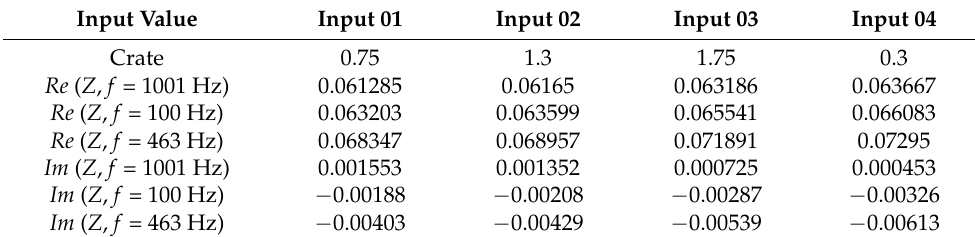
Table 2. Input parameters of the ANN-based model.